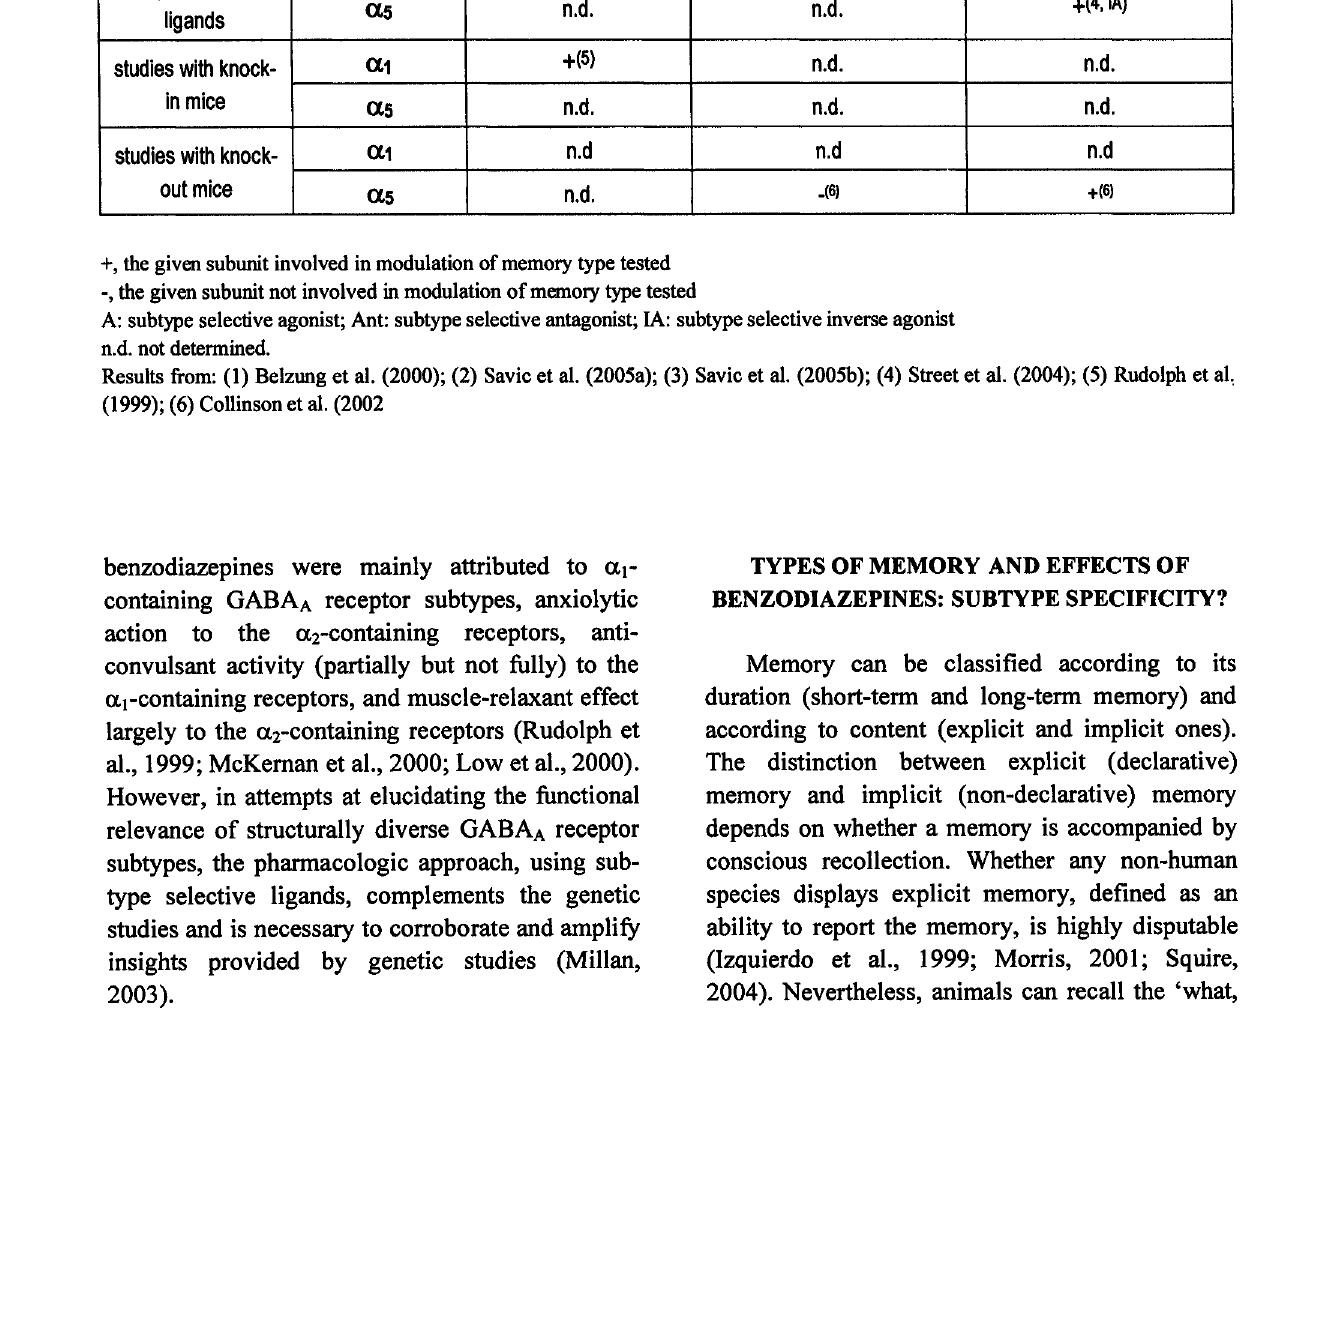
Involvement of different GABAA subunits in memory effects of benzodiazepines: findings from studies with subtype selective ligands vs. knock-in mice vs. knock-out mice. Only behavioral tests used in at least two types of studies are